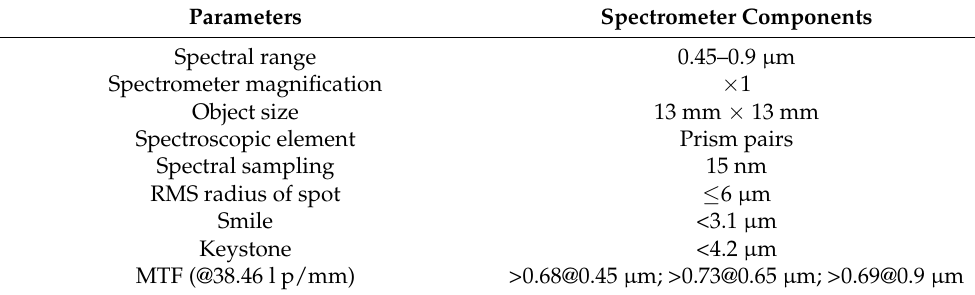
Table 1. Detailed optical